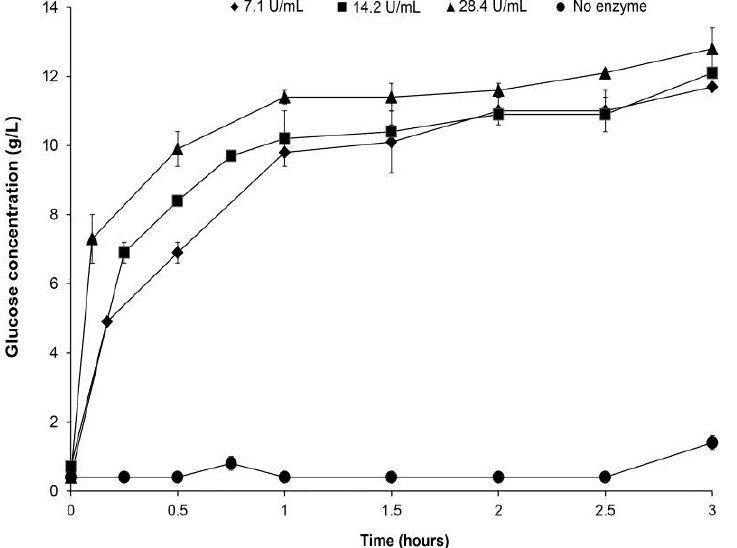
Figure 4. Hydrolysis of mixed food waste for glucose production in the presence of crude GA extract with (  ) no enzyme, (  ) 7.1 U/mL, (  ) 14.2 U/mL and (▲) 28.4 U/mL at pH 5.5 and 55 °C for 3 h. Experiments were duplicated. The mean values are plotted and the standard errors are